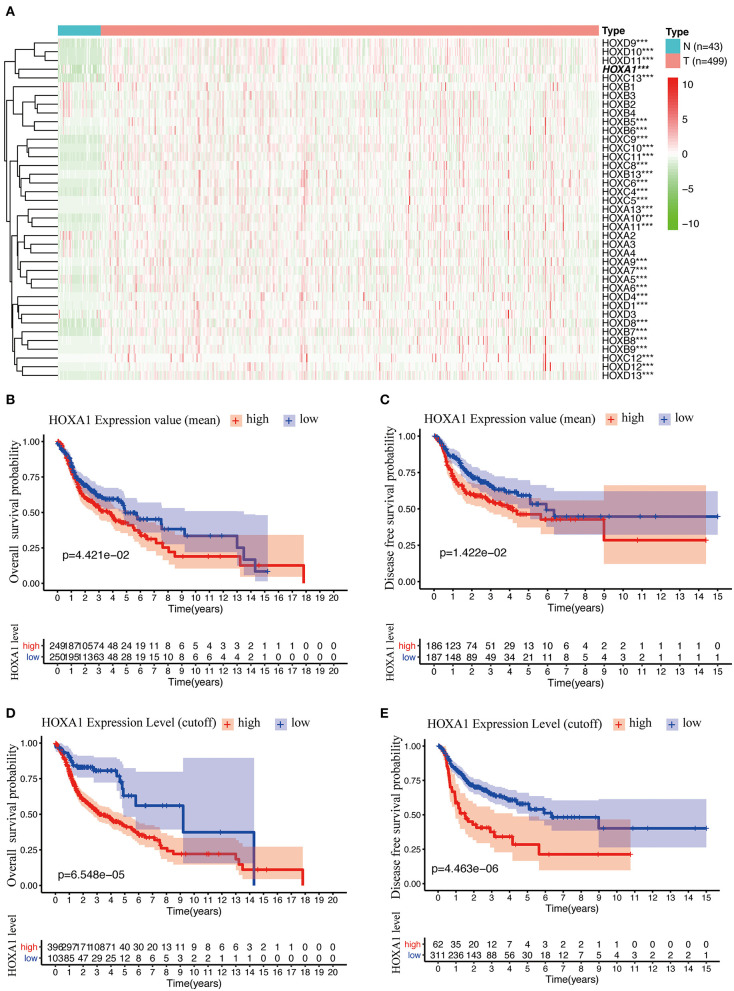
Differentially Expression and Prognostic Value OF HOX Genes in HNSCC. (A) Heatmap of HOX genes family included 30 differentially expressed genes (DEGs) in 499 tumor tissues compared with 43 para-carcinoma tissues based on TCGA-HNSC DATA. (B) Kaplan-Meier curve analysis of overall survival of TCGA-HNSC patients in high- and low-HOXA1 expression (mean value) groups (p = 4.421e−02). (C) Kaplan-Meier curve analysis of disease-free survival of TCGA-HNSC patients in high- and low-HOXA1 expression (mean value) groups (p = 1.422e−02). (D) Kaplan-Meier curve analysis of overall survival of TCGA-HNSC patients in high- and low-HOXA1 level (cut-off value) groups (p = 6.548e−05). (E) Kaplan-Meier curve analysis of disease-free survival of TCGA-HNSC patients in high- and low-HOXA1 level (cut-off value) groups (p = 4.463e−06). ***P < 0.001.